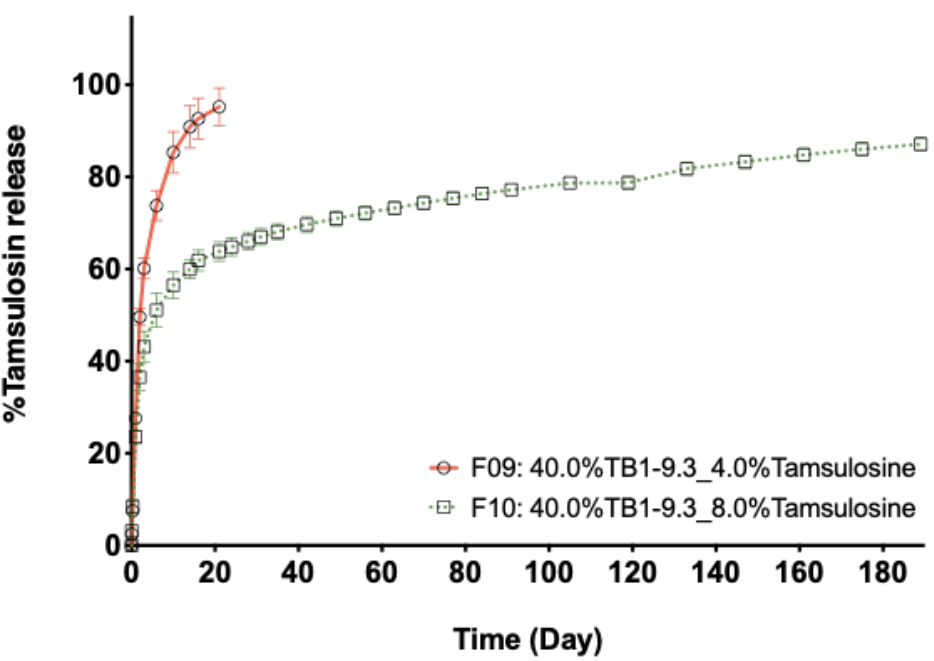
Figure 5. Tamsulosin release from PEG–PTMC solution (F09) and suspension (F10) formulations with the same type and content of triblock PEG–PTMC